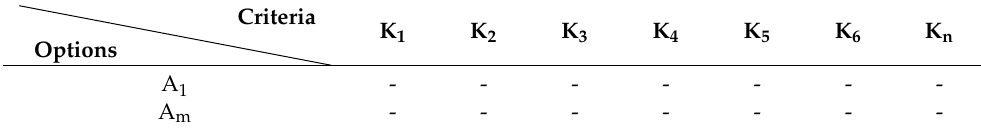
Table 7. Additional matrix